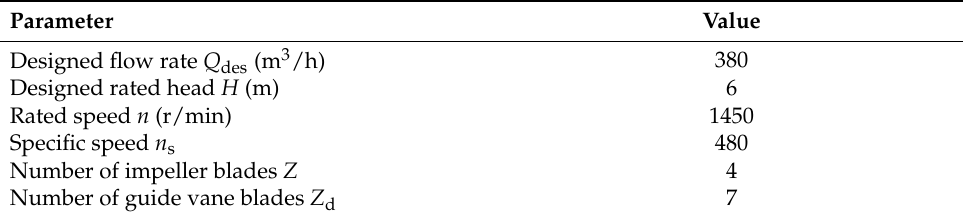
Table 1. Parameters of mixed-flow